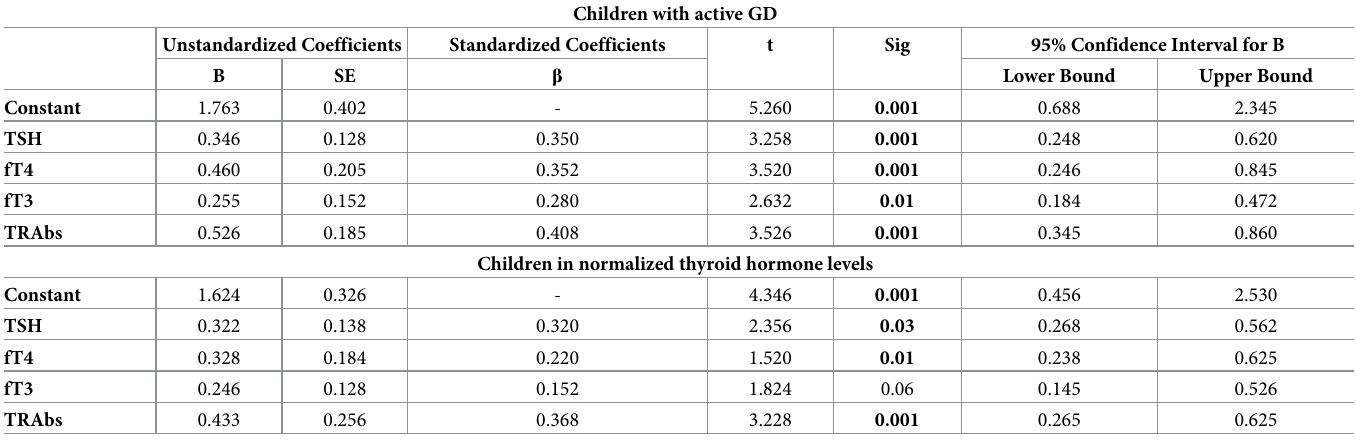
Table 4. Regression analysis for variables which predict behavioral